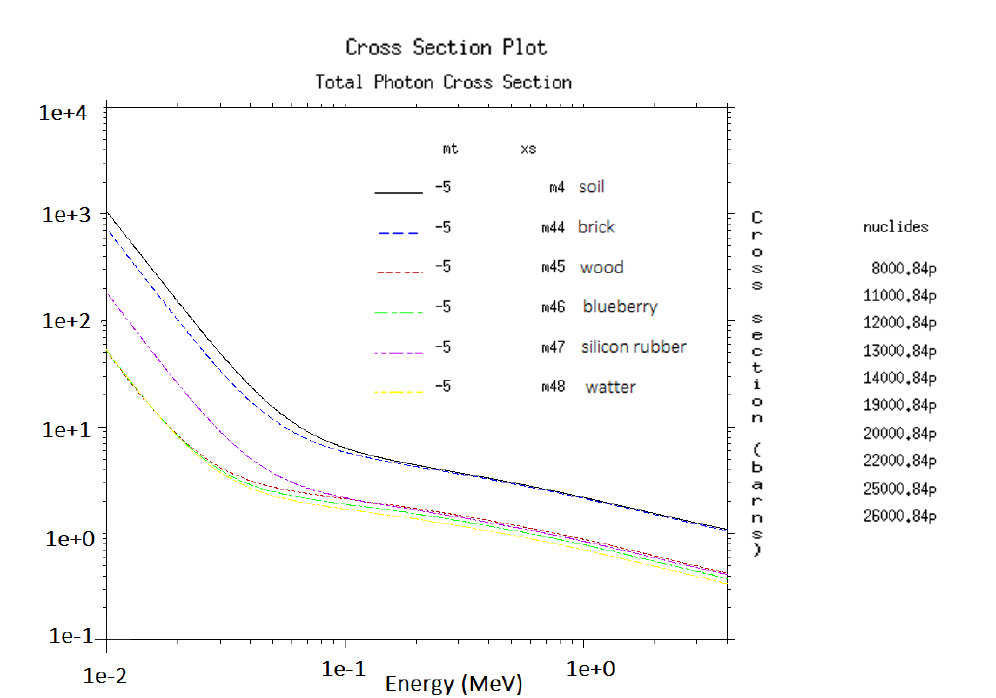
Figure 3. The example of cross sections for materials used in the model.